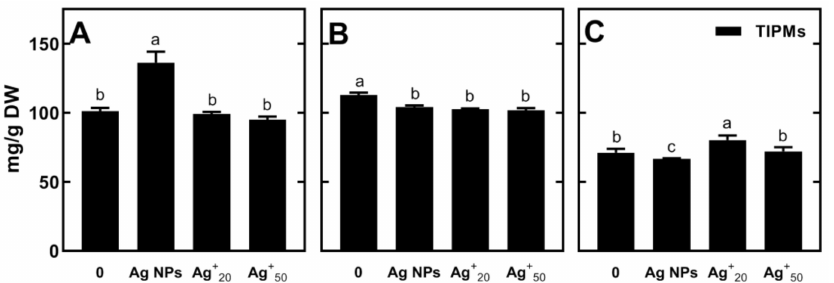
Figure 2. The total contents of identified polar metabolites (TIPMs) in the roots ( A ), epicotyls ( B ) and cotyledons ( C ) of 4-day-old pea seedlings (cv. Tarchalska) developing in double-distilled water (0), Ag NPs suspension (20 mg/L) and AgNO 3 solutions (20 and 50 mg/L of Ag + ions). Results are means ( n = 3) + SD. The same letters (a–c) above the bars indicate no significant ( p < 0.05) differences according to ANOVA and Tukey post-hoc test.